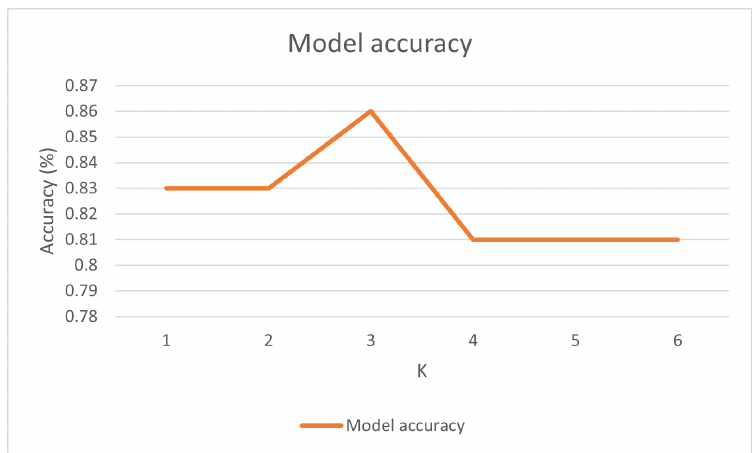
Figure 15. Accuracy of K-NN classifier with different K